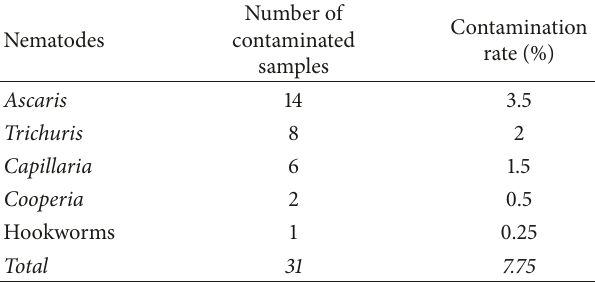
Table 1: Contamination rate of soil samples with identified nema- todes.